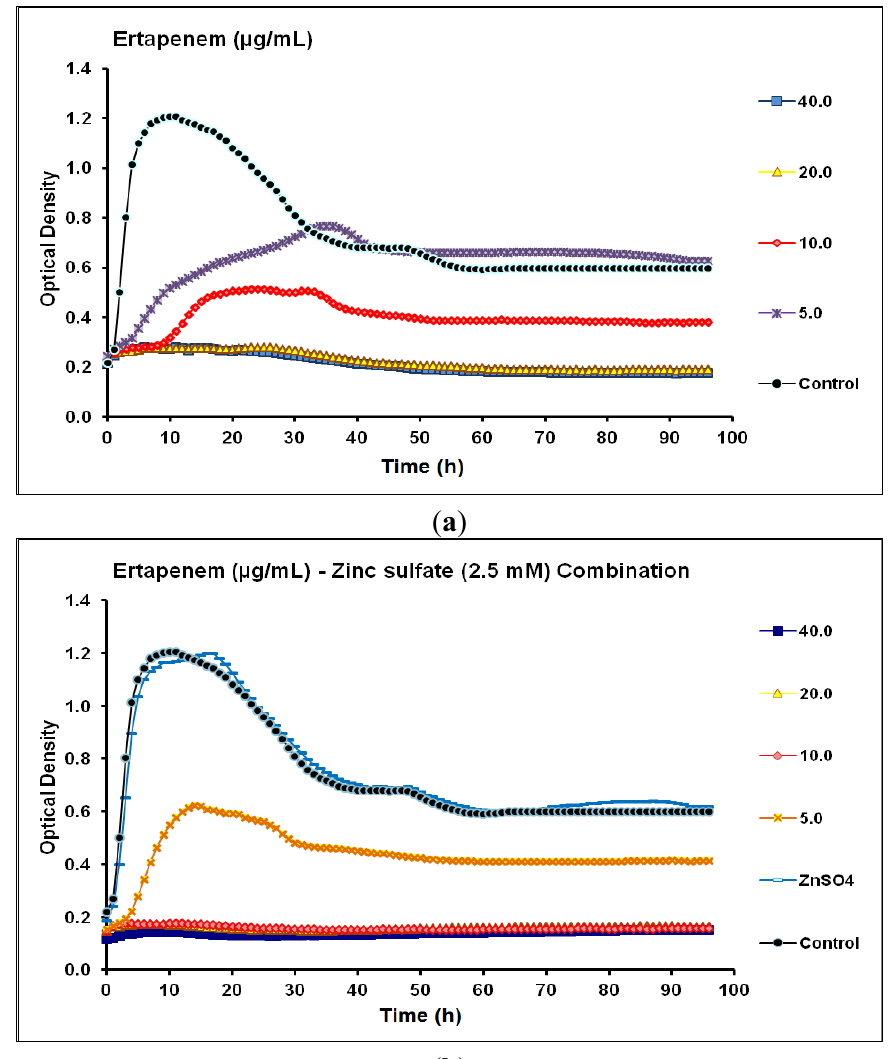
Figure 6. Real-time data showing the effect of ( a ) Ertapenem alone (5.0–40.0 µg/mL) and ( b ) Ertapenem (5.0–40.0 µg/mL) in combination with zinc sulfate (2.5 mM) on P . aeruginosa CCIN34519 biofilm as monitored by the Bioscreen C over 96 h. Control represents cation adjusted Mueller Hinton II broth (CAMH) while, ZnSO